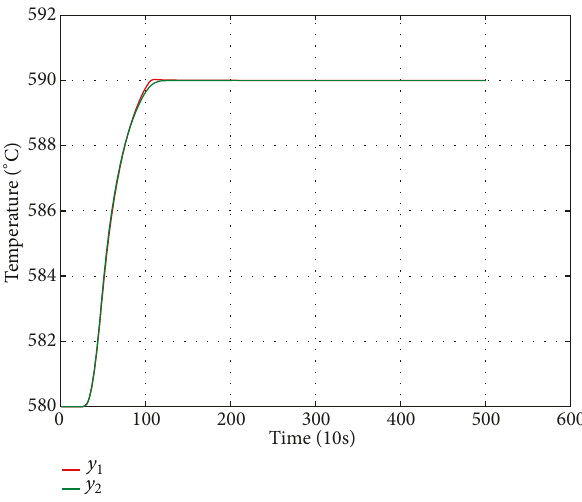
Figure 2: The variation curveof reheatsteam temperaturewhen the load of generator unit is 400MW, 𝑢 𝑗 ∈ [0,15], Δ𝑢 𝑗 = 0.5 .